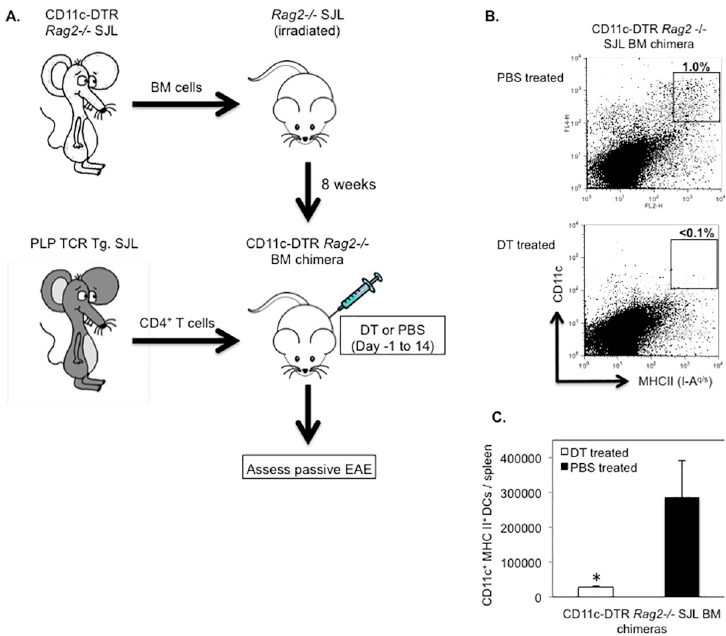
Fig 9. Efficient DC ablation in long term DT treated CD11c-DTR Rag2 -/- SJL BM chimeras. (A) Schematic representation of the generation of CD11c-DTR Rag2 -/- SJL BM chimeric mice and assessment of their susceptibility to passive EAE by transfer of CD4 + T cells from na ï ve PLP TCR transgenic SJL mice. (B, C) Splenic DCs from CD11c- DTR Rag2 -/- SJL BM chimeras that had been treated with DT (n = 4) or PBS (n = 3) on consecutive days for two weeks were assessed by flow cytometry at the end of the treatment. (B) Representative frequency (number above boxed gates, %) or (C) Mean absolute numbers ± SEM of CD11c + MHC II (IA- q ) + DCs in live splenocytes from long term treated CD11c-DTR Rag2 -/- SJL BM chimeras of three independent experiments are shown. � p < 0.03 (Student’s t test).